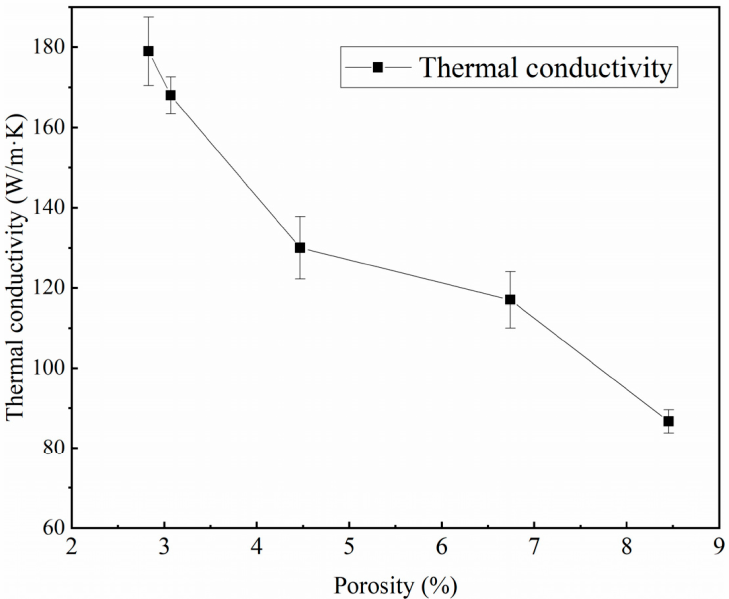
Figure 11. Thermal conductivity of composite materials with different porosity.